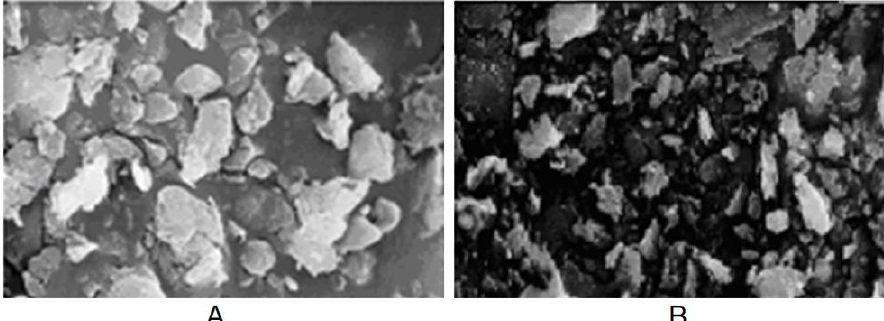
Figure 1. SEM micrographs of Capsicum frutescens processed by different treatments. A = super fine ground red pepper powder (44  m); B = super fine ground red pepper with 5% Na 2 CO 3 added after grinding (44 